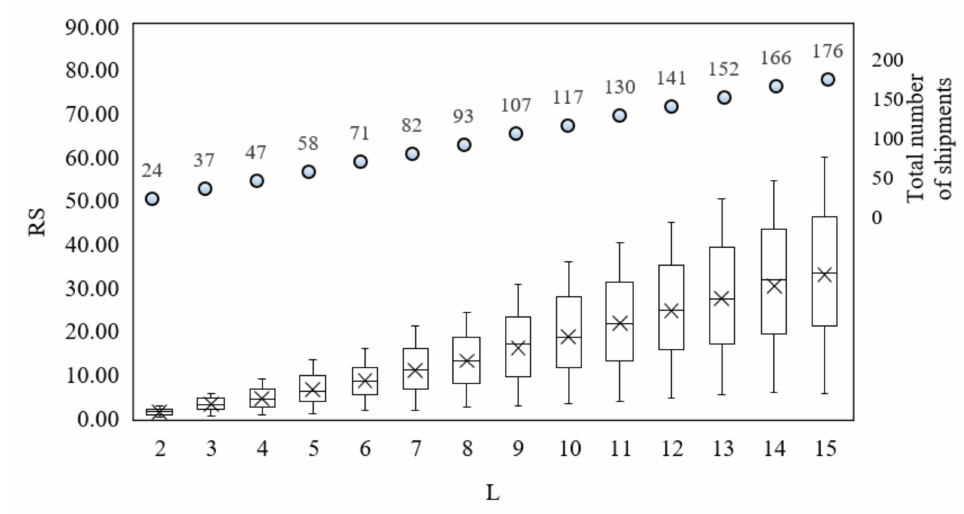
Figure 10. RS and average total number of shipments in the